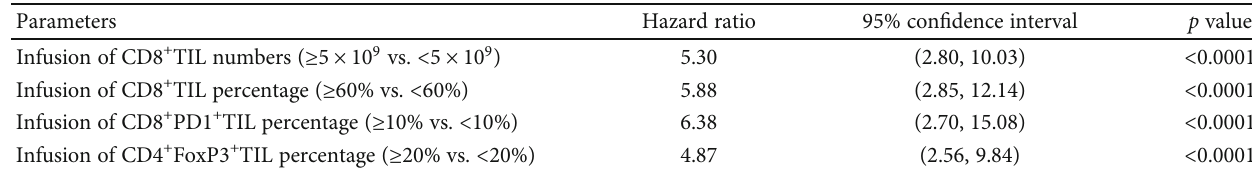
Table 6: Multivariate analysis